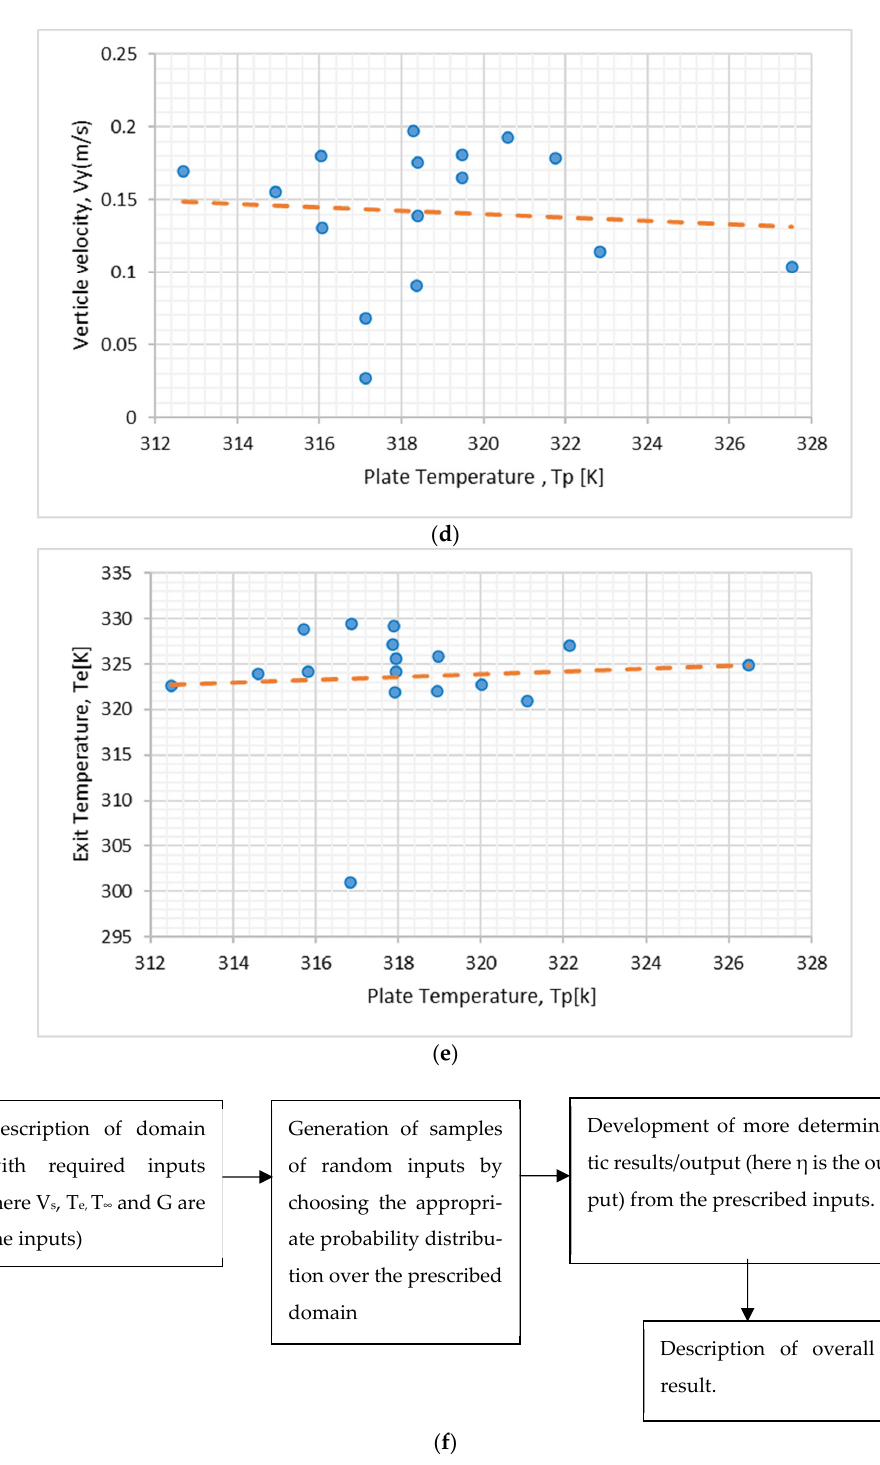
Figure 5. ( a ) Scatter plot for the distribution of mean Y ‐ velocity (fitted value) versus location. ( b ) Scatter plot of Y ‐ velocity of T exit versus residuals. ( c ) Scatter plot of T exit location versus residuals. ( d ) Cavity vertical velocity versus plate temperature with regression line. ( e ) Exit temperature versus plate temperature with regression line. ( f ) Flow diagram of Monte Carlo technique.